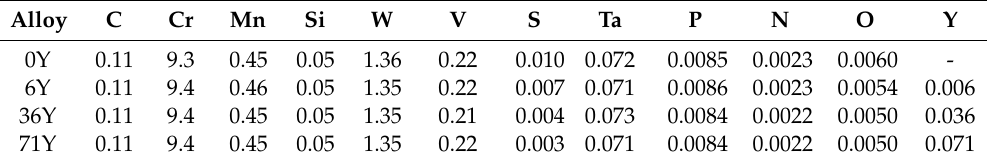
Table 1. Chemical composition of the investigated China low activation martensitic (CLAM) alloys